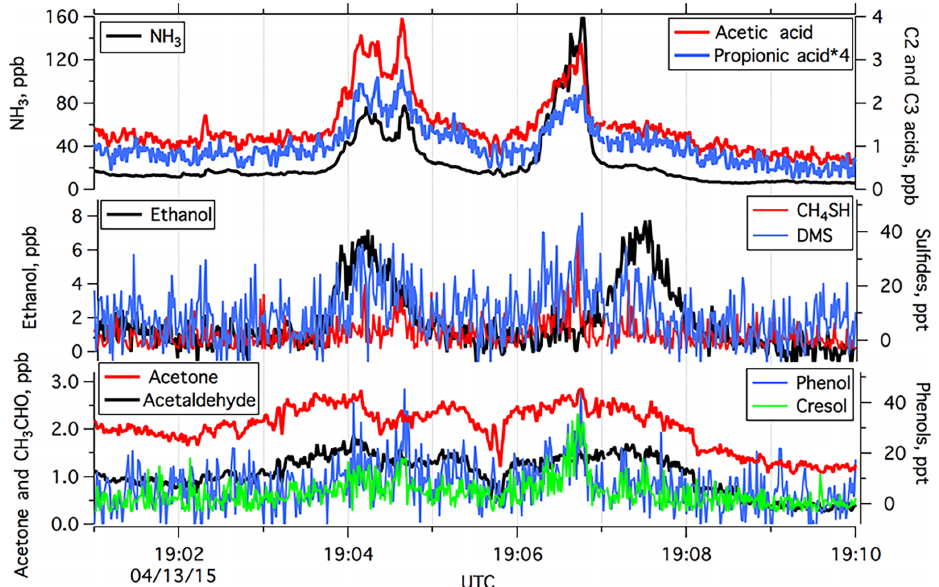
Figure 6. Time series of NH 3 and various VOC species of two agricultural plumes measured from NOAA WP-3D on 13 April 2015 during the SONGNEX campaign.